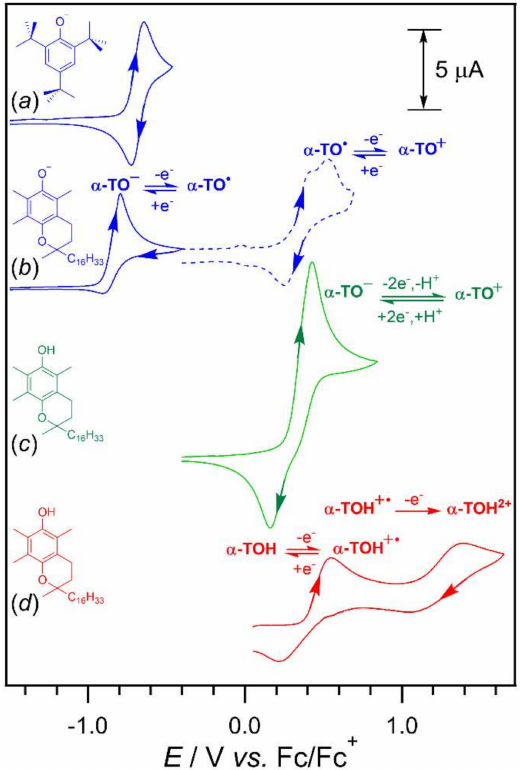
Figure 2. Cyclic voltammograms of ca. 2 mM substrates in CH 3 CN containing 0.25 M n –Bu 4 NPF 6 recorded at 0.1 V s − 1 scan rate at 1 mm diameter planar circular Pt or glassy carbon electrodes at 22 ( ± 2) ◦ C, under ( a , b ) basic, ( c ) approximately neutral, and ( d ) acidic conditions. ( a , b ) Phenolates prepared by reacting starting phenols with a molar equivalent of dry Et 4 NPF 6 . ( c ) No added acid or base. ( d ) Addition of 0.1 M neat CF 3 SO 3 H